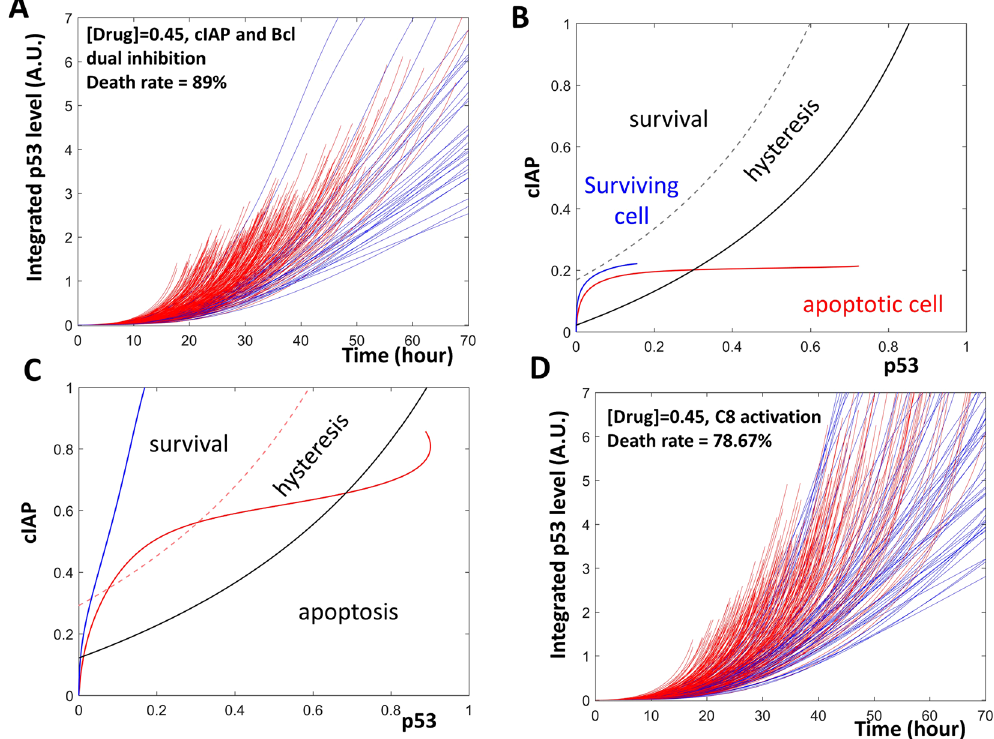
Figure 6. New strategies designed to combat fractional killing. ( A ) Time series simulations with a population of cells treated with cisplatin, a CIAP inhibitor, and a BCL inhibitor. ( B ) Inhibition of BCL expands the area corresponding to apoptosis; while inhibition of CIAP keeps the time dependent trajectories of the cells at the bottom of the plane. ( C ) The black solid curve and the red solid curve indicate the BAXm activation threshold before and after Caspase8 activation, respectively. The area at the right of the BAXm activation threshold curve defines the apoptosis area. Hence, the activation of Caspase8 expands the area of apoptosis. ( D ) Time series simulations with a population of cells treated with cisplatin and a Caspase8